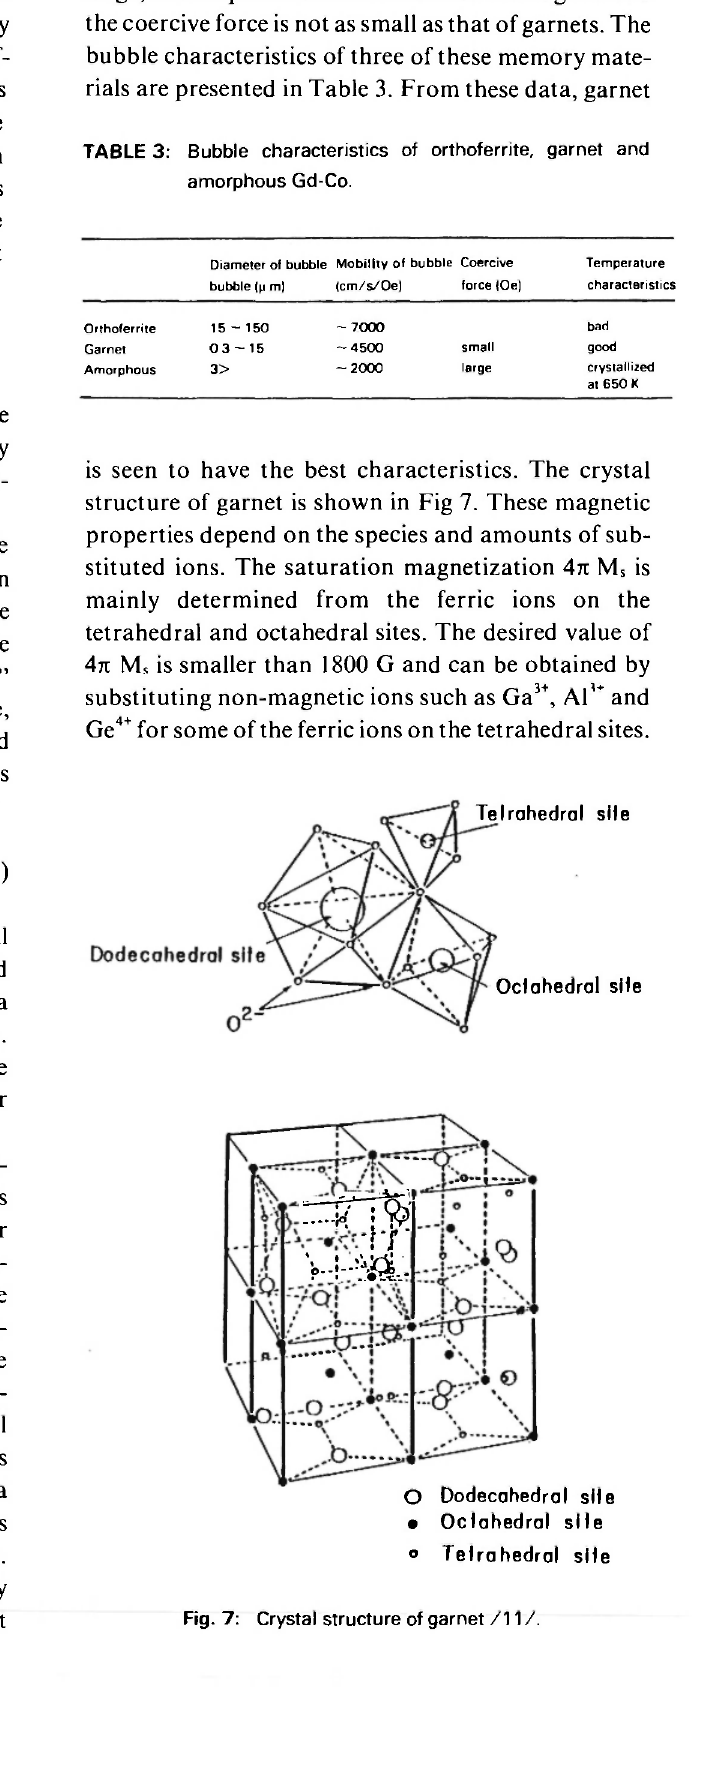
TABLE 3: Bubble characteristics of orthoferrite, garnet and amorphous Gd-Co.